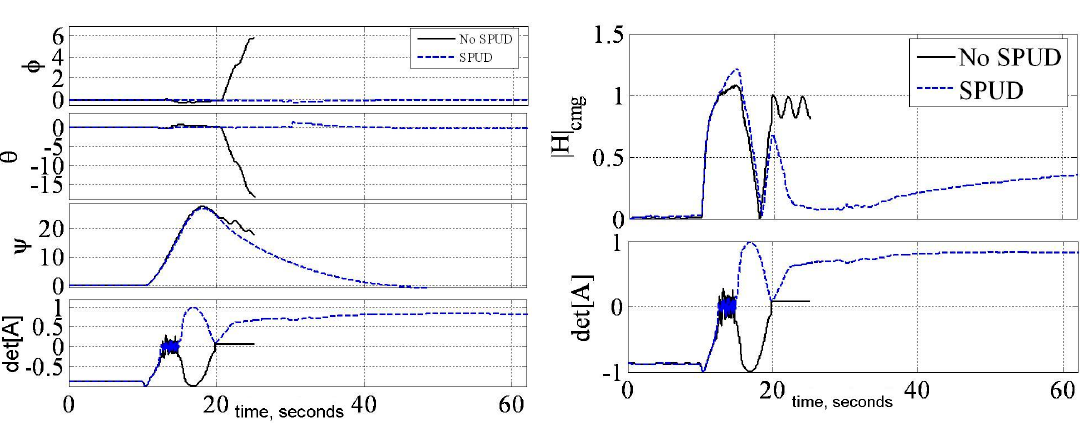
12 of 15 Figure 11. EXPERIMENTATION: direct comparison with SPUD versus without SPUD. Potential hardware damage associated with loss of control authority when the singularity was